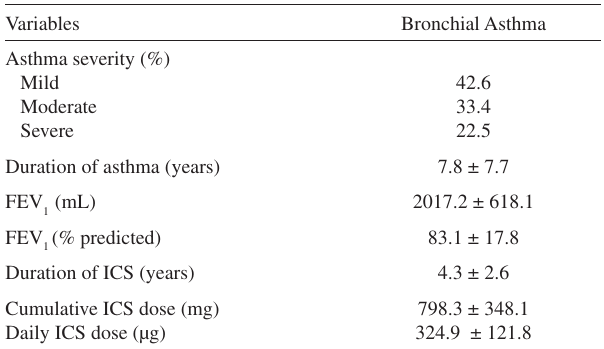
Table 2 - Asthma-related parameters and pulmonary function test values for asthma